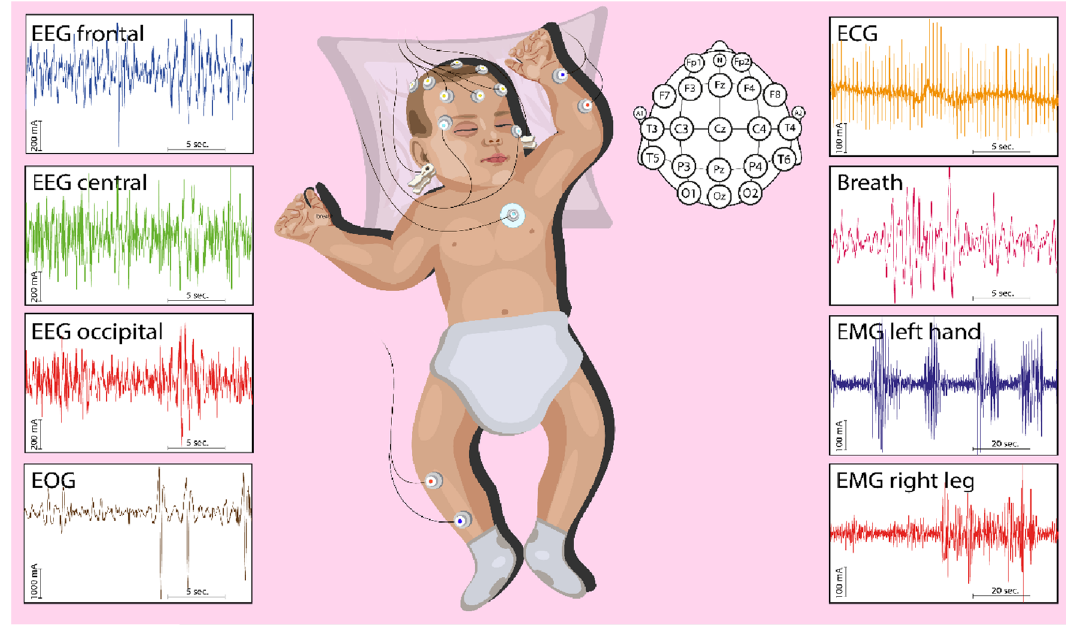
Figure 6. Newborn monitoring scheme, including EEG, EOG, ECG, EMG Left Arm, and EMG Right Leg. The diagram is supplemented with several fragments of EEG, ECG, EMG, and EOG recordings for one of the newborns in group I (with a gestational age of 40.3 weeks). For clarity, fragments of biomedical records in the figure are presented at different